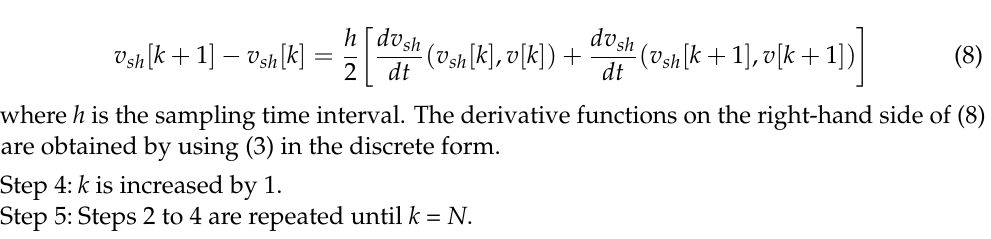
Algorithm 1 C urrent Predictor Pseudo-Code